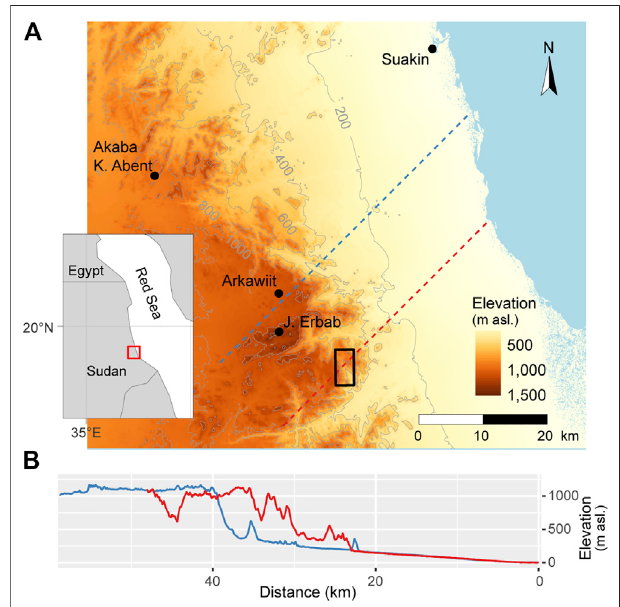
FIGURE1|(A) Mapofstudyareaandinsetshowingitsregionallocation (red outline). Dashed lines indicate the dominant wind direction, i.e., from NE and crosses Arkawiit (blue) and Baryakay (red). Study area in Baryakay is outlined in black (B) Altitude pro fi les for the dashed lines in (A) from coastline (to the right) across the coastal plain to the plateau of Arkawiit and Baryakay. Since Tombat is endangered the study site will not be named, nor will maps show coordinates or details that can precisely locate the site investigated. Our own artwork. Topographic information is from